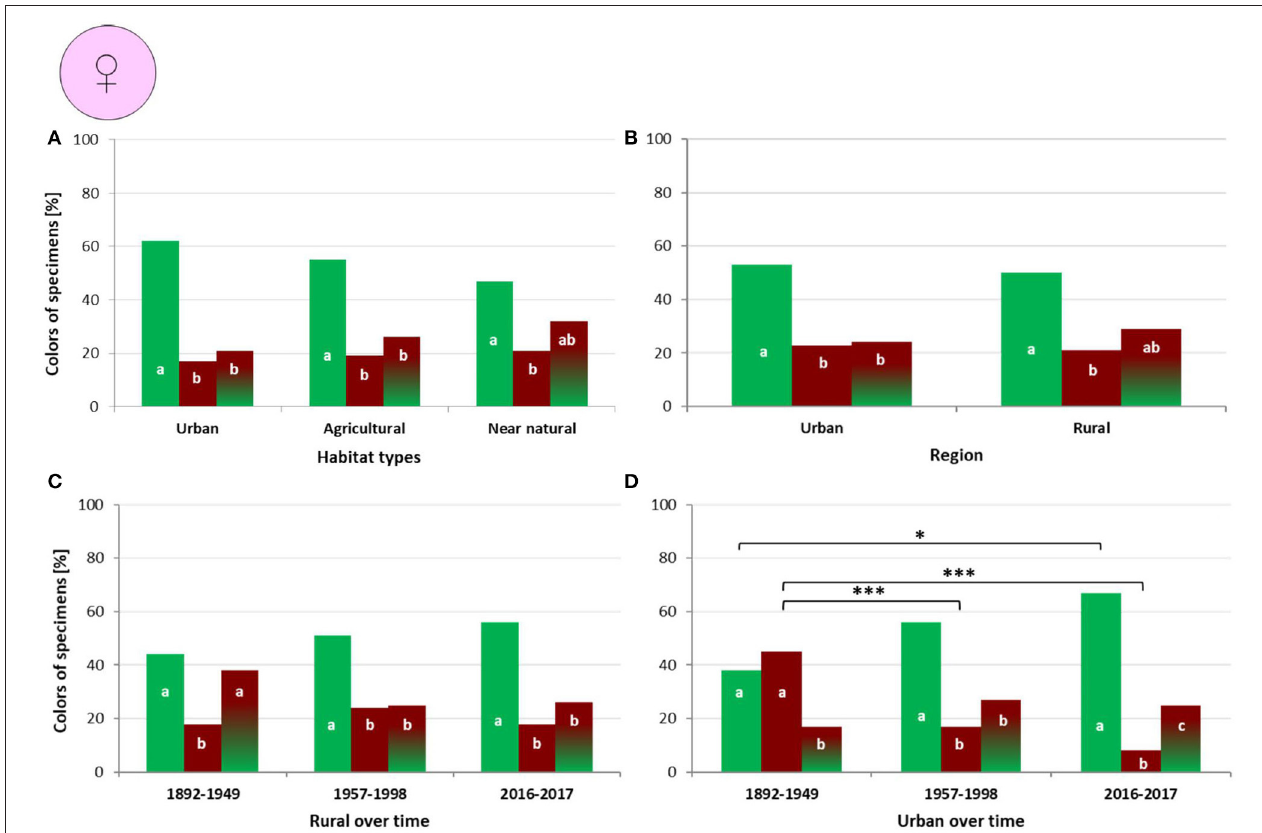
FIGURE 4 | Percentage of female Harpalus affinis color morphs in different habitat types (A) , regions with different urbanization level (B) , and within a particular region during different time periods (C,D) ; different letters indicate significant differences in frequencies of the three color morphs; brackets with stars indicate significant difference between time periods (* p < 0.05; *** p < 0.01).